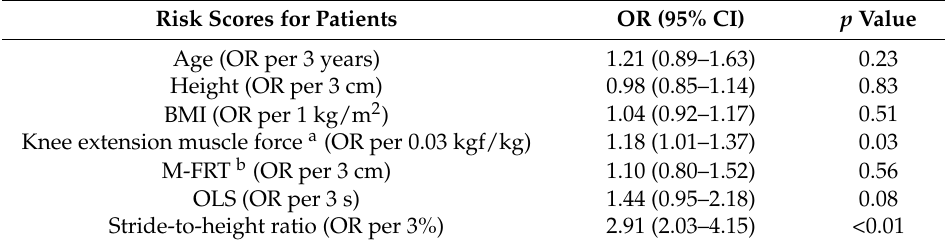
Table 2. Risk scores for patients able to walk 1.0 m/s or faster in the maximum walking speed test.